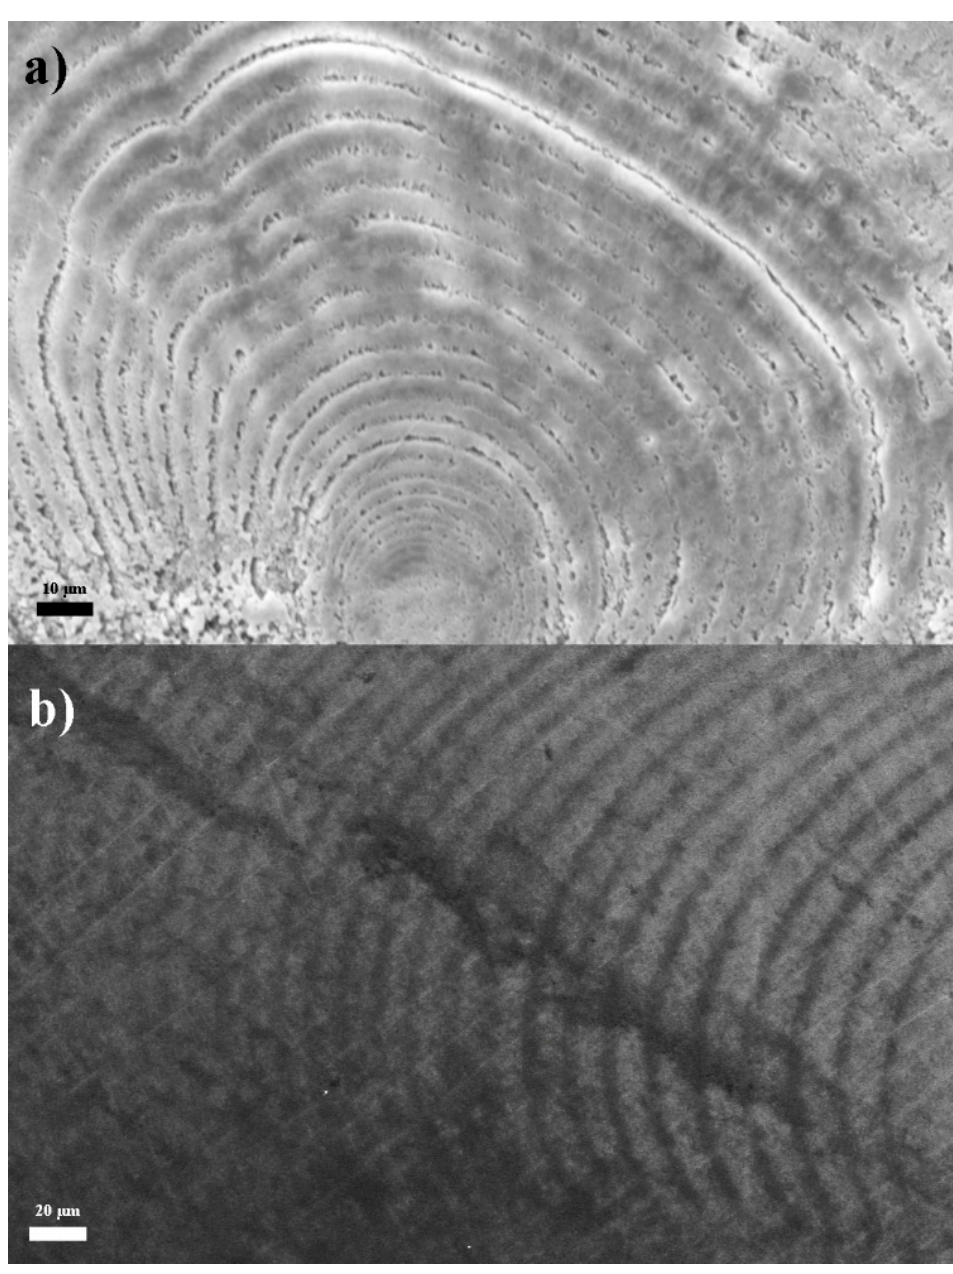
Figure 5. Sagittal section of an otolith of Myctophum punctatum observed by scanning electron microscope, showing the growth pattern in the central zone (CZ) and the particular of growth increments in the external zone (EZ) (( a , b ), respectively).